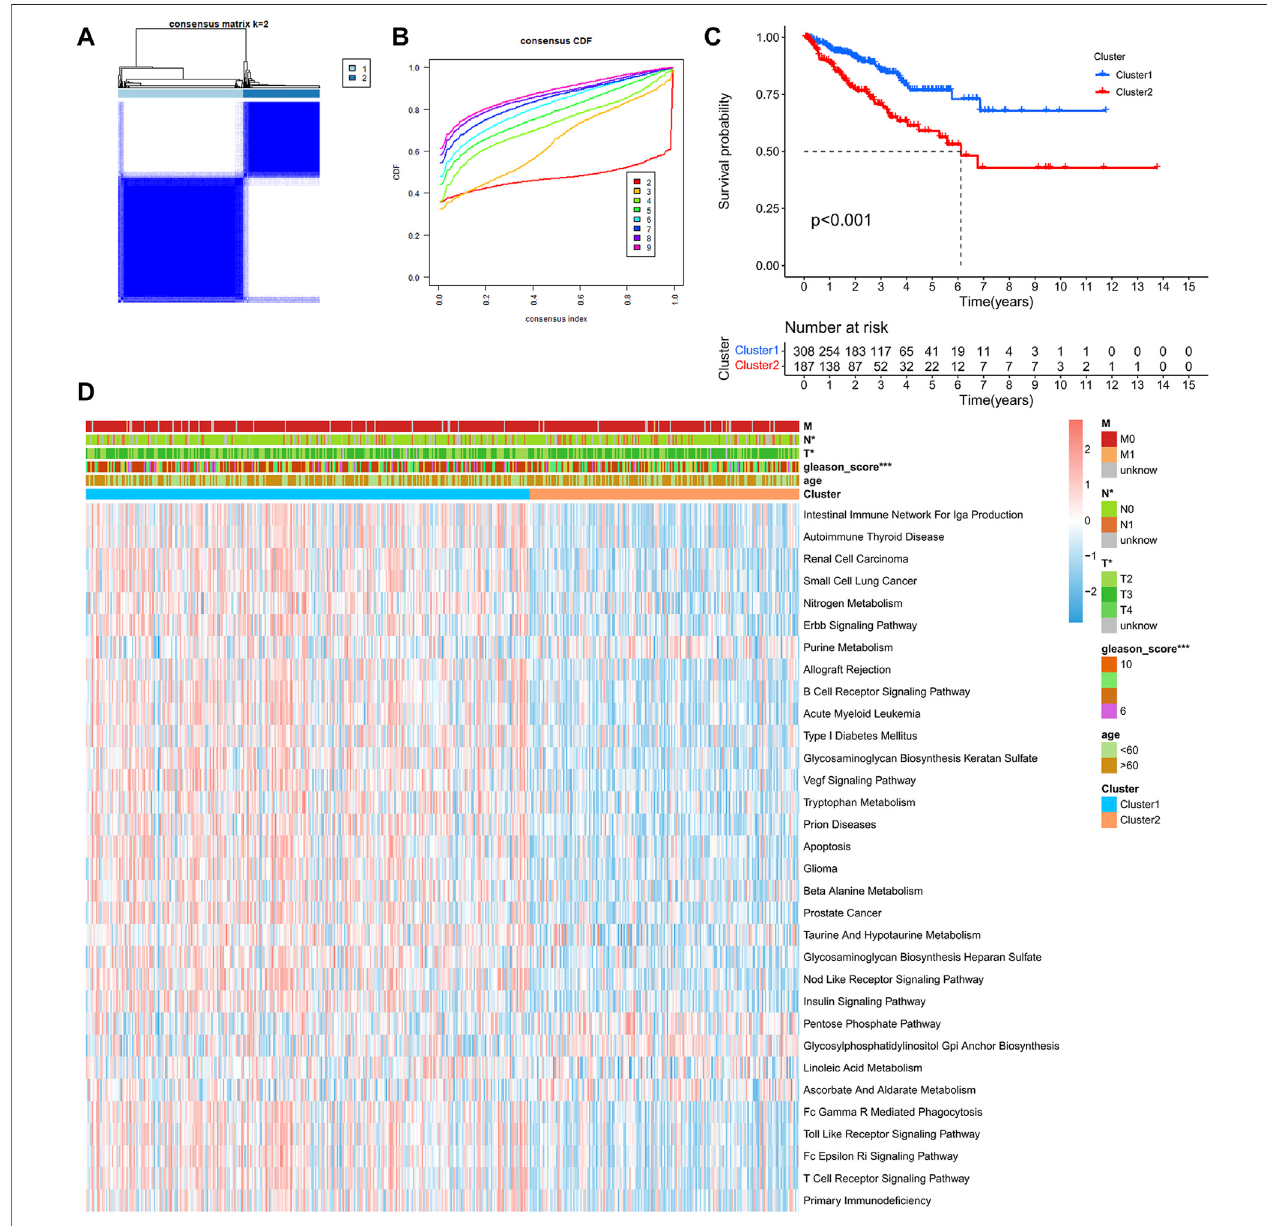
FIGURE 3 | Identi fi cation of PCa subclasses by unsupervised consensus clustering: (A) Matrix heatmap of the K-means clustering using 1,051 mutated genes betweenprimaryand metastatic prostate cancer. (B) CDF curve oftheclusteringresult. (C) Kaplan – Meier survivalcurveofPFS between different clusters. (D) Heatmap of GSVA enrichment based on KEGG pathways between different clusters. (* p < 0.05, ** p < 0.01, *** p < 0.001).